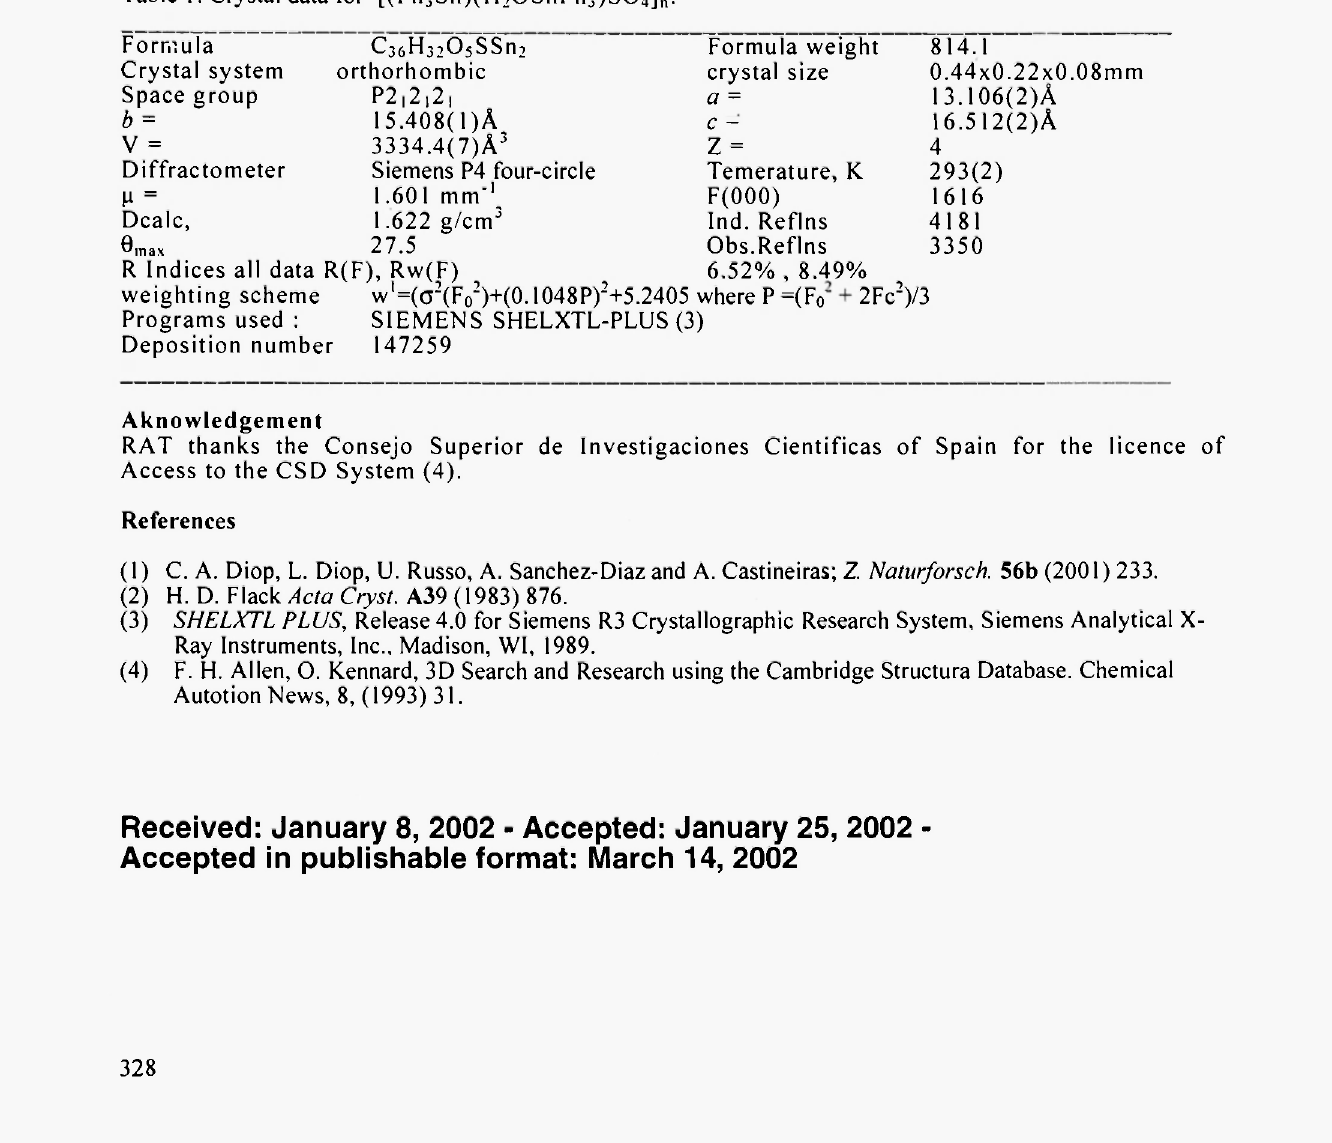
Table 1: Crystal data for [(Ph 3 Sn)(H 2 0SnPh 3 )S0 4 ] n